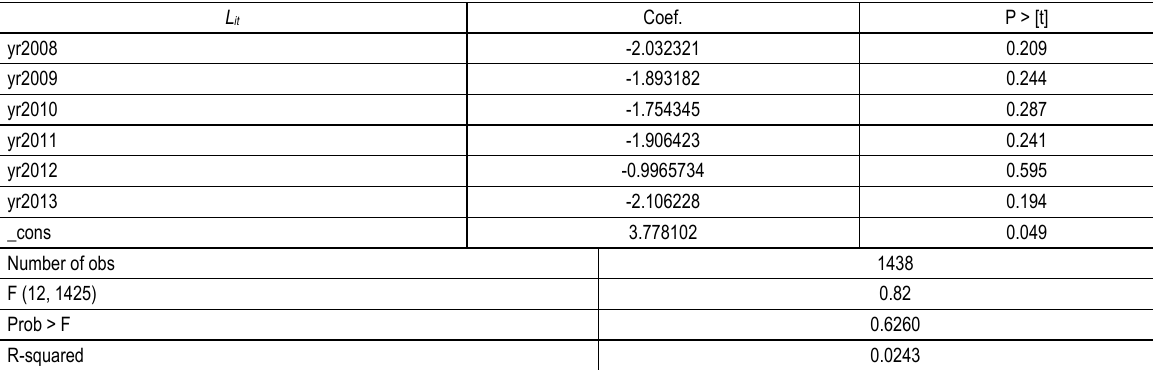
Table 5 (cont.). Regression results, Model III